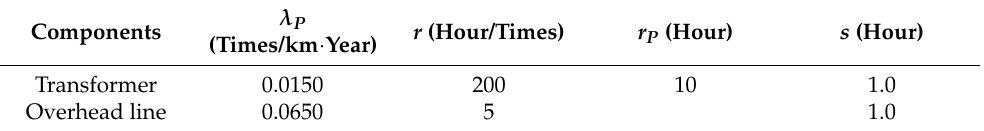
Table A1. Component reliability raw